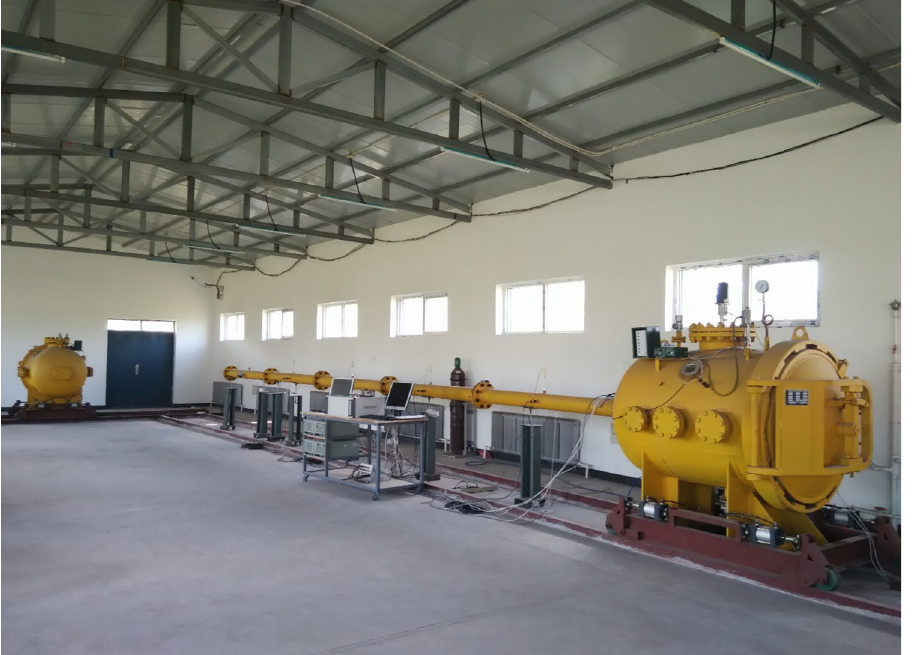
Fig 2. The testing platform of the tube gas explosion: Experimental setup.